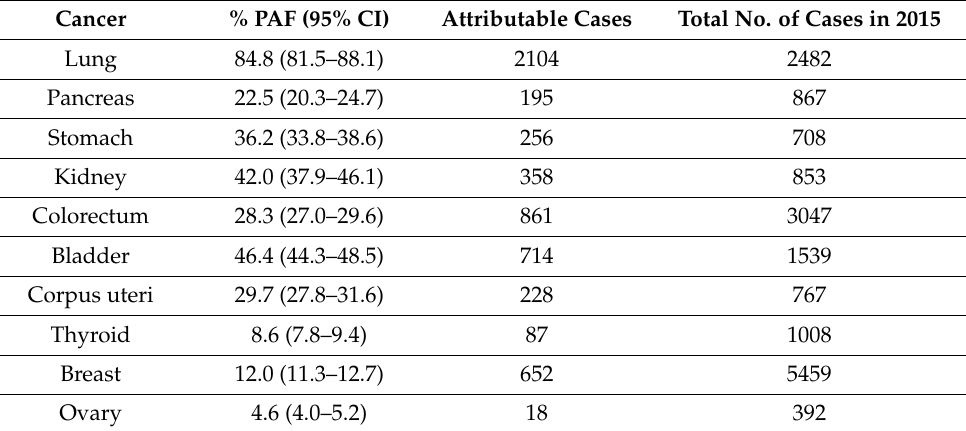
Table 5. Estimated proportion and number of incident cancer cases attributable to all evaluated risk factors and estimated total number of cancer cases in adults aged 30 years and older in Israel in 2015, by cancer type.